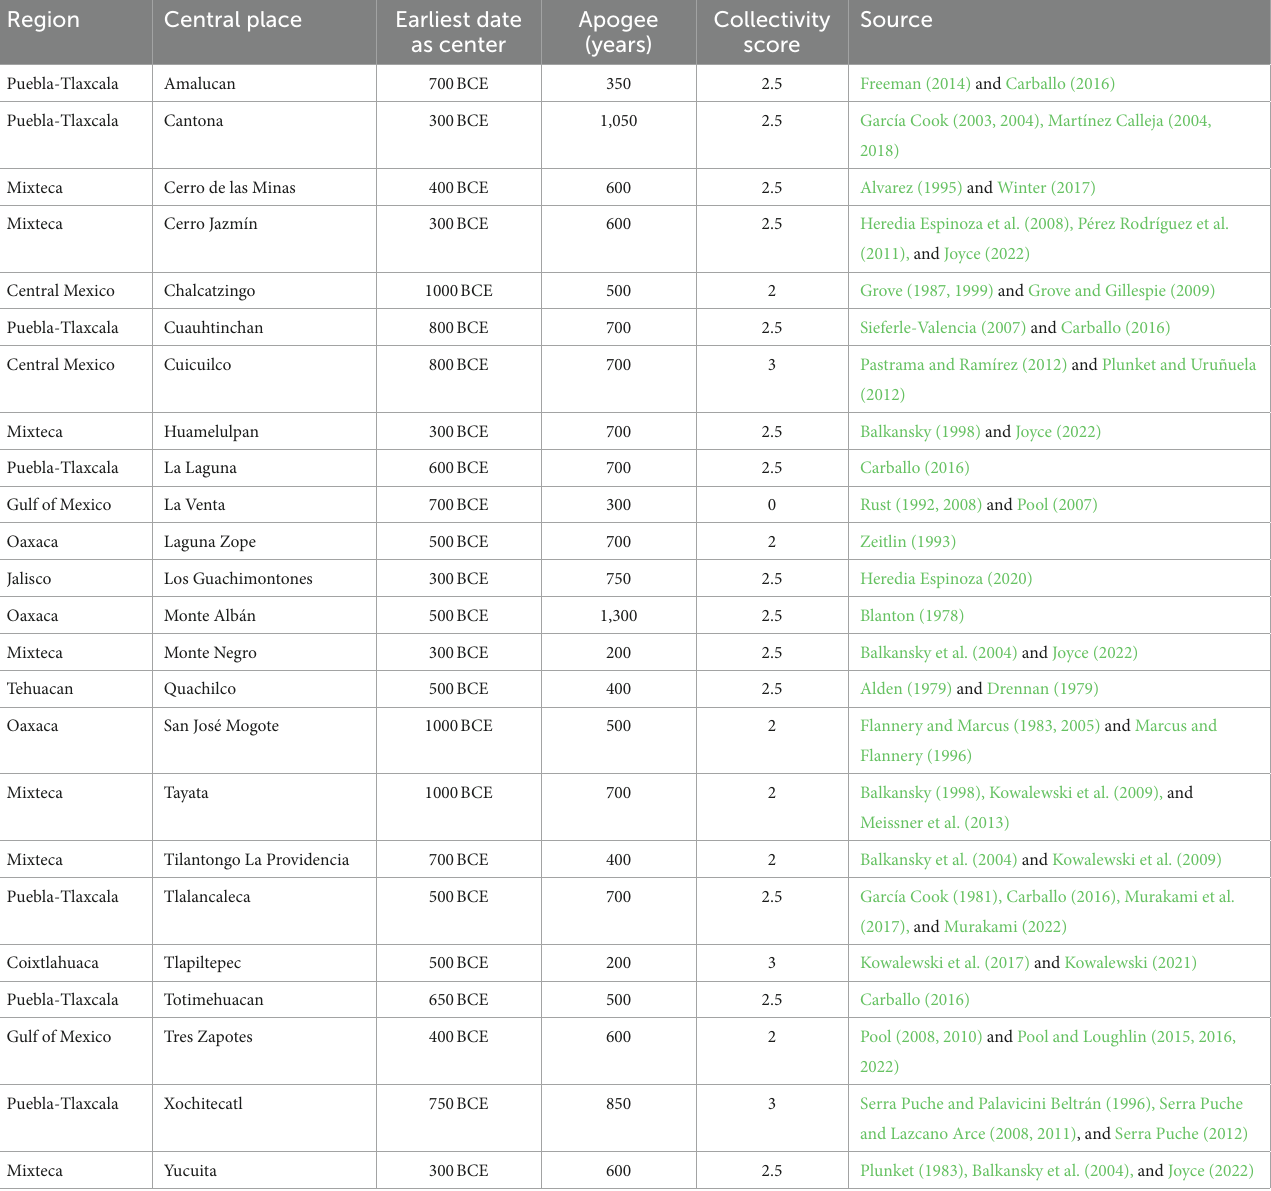
TABLE 2 Sample of 24 early central places in western